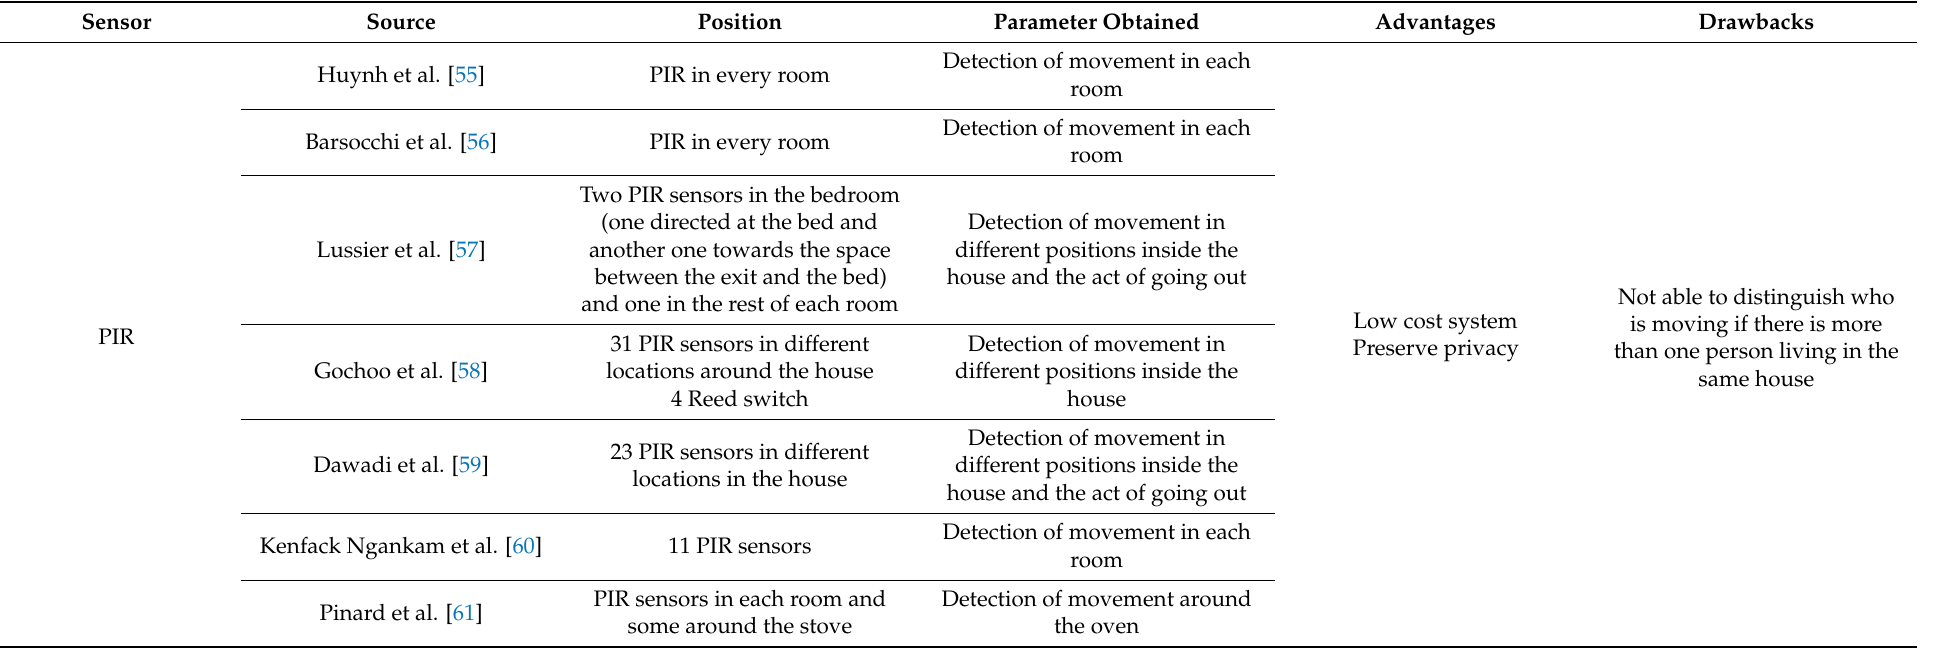
Table 4. Advantages and drawbacks of the sensors used by the authors in their